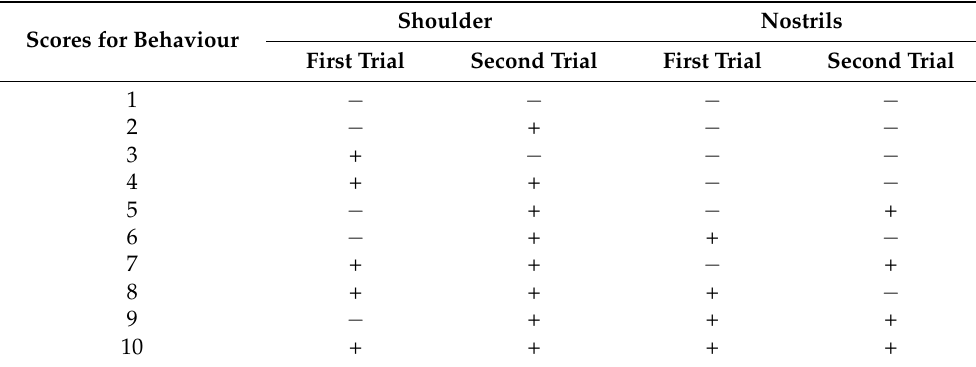
Table 2. Score scale for the response of mares in the test of stroke acceptance.